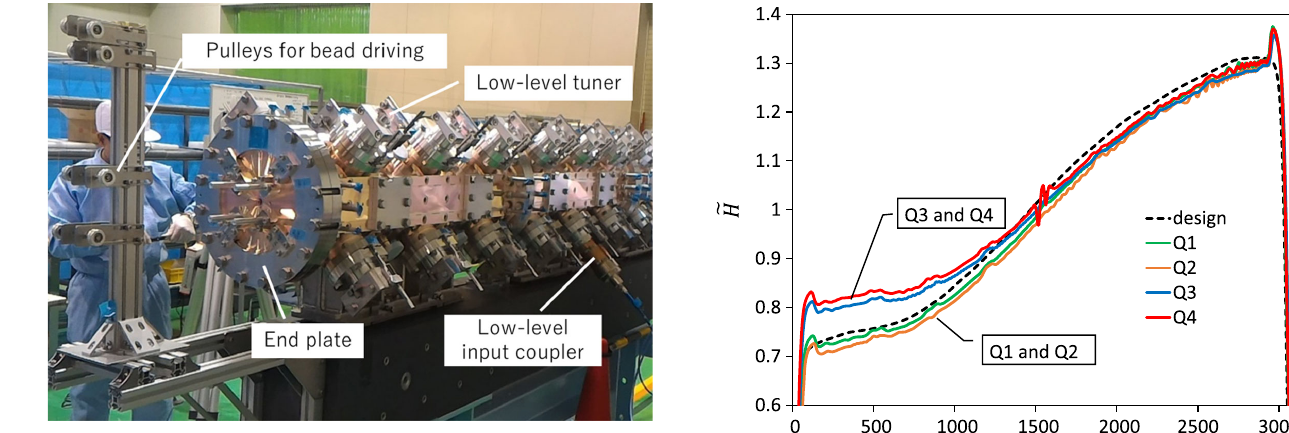
12. Setup of the bead-perturbation